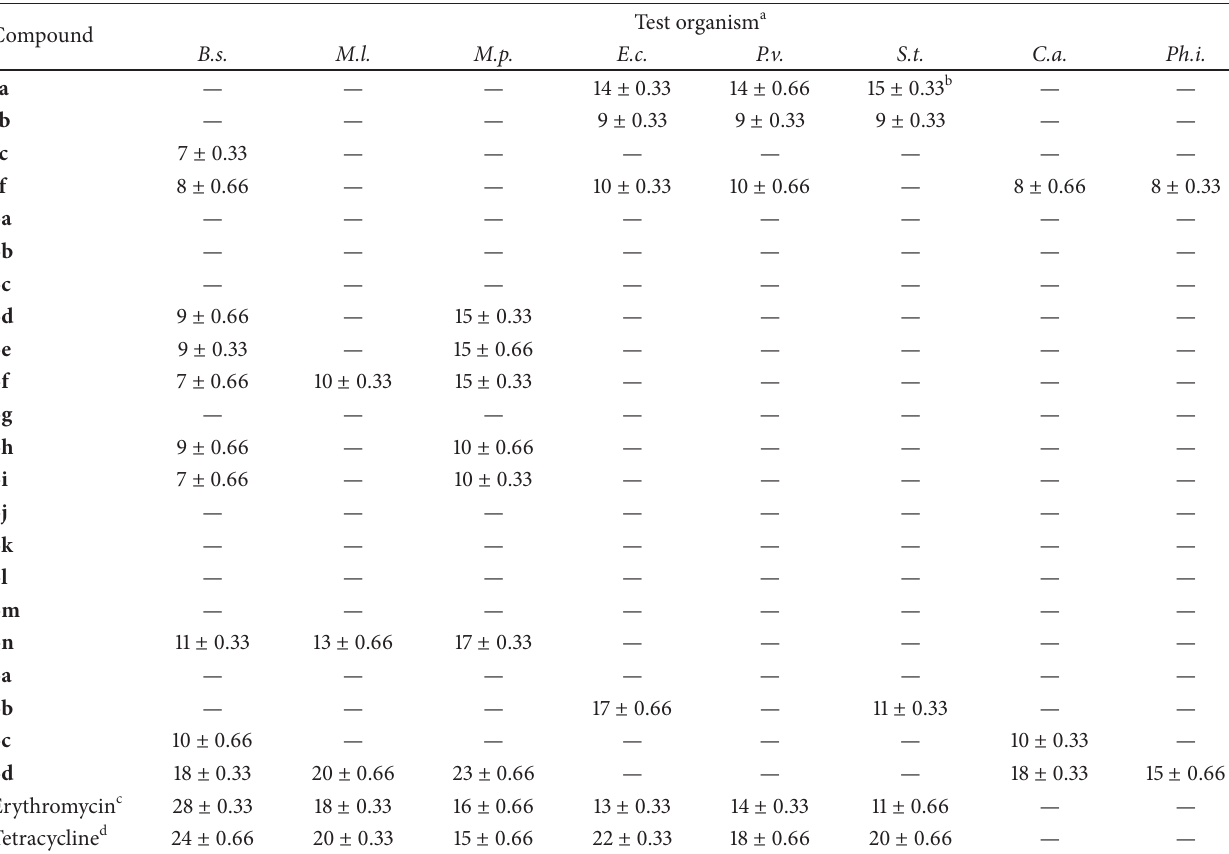
Table 1: The antimicrobial activities of the synthesized isatin derivatives expressed as inhibition zones of growth in mm against the tested pathogenic